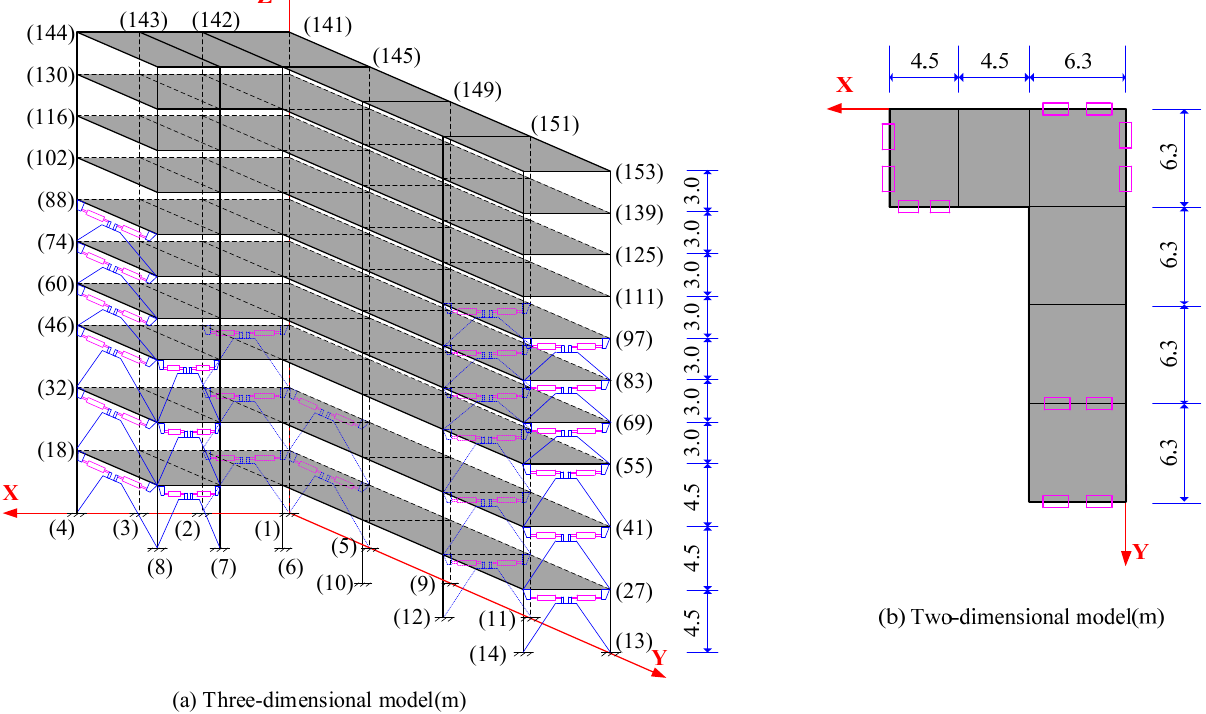
Figure 7. Calculation model of the L-shaped frame structure with MRDs.